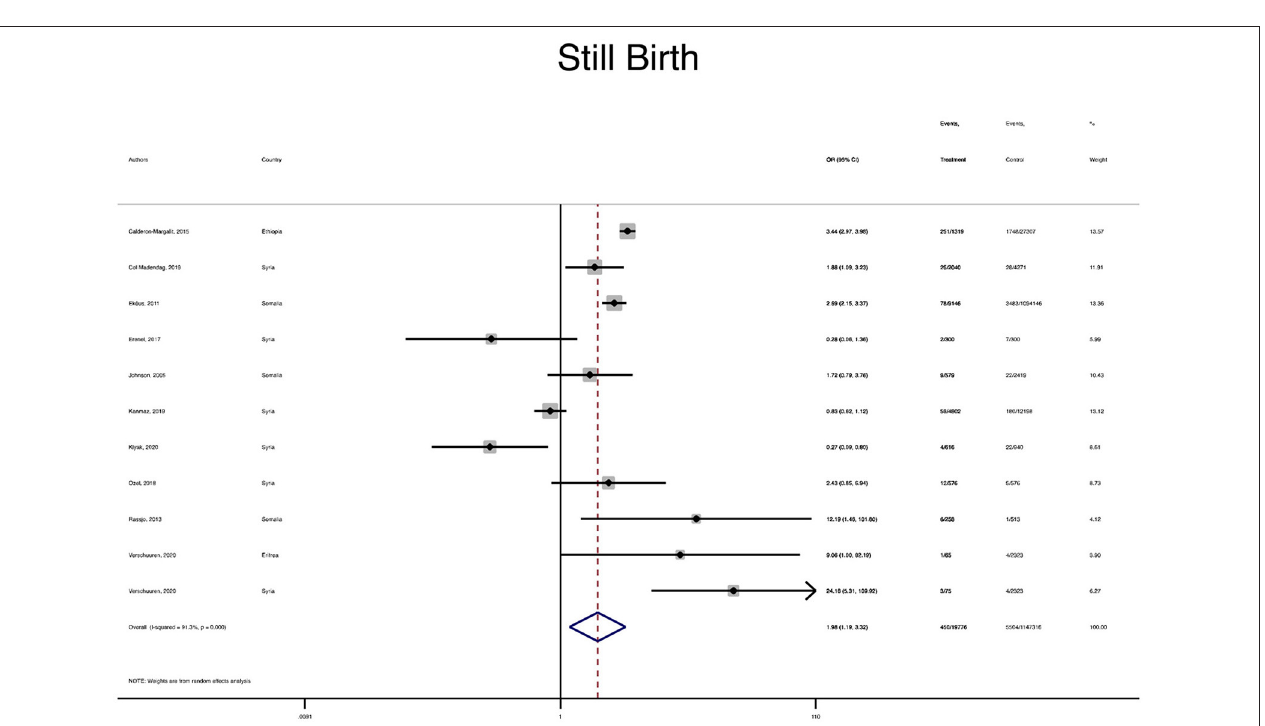
FIGURE 4 | A forest plot of the pooled odds ratio of still birth in the immigrant and native-origin populations.